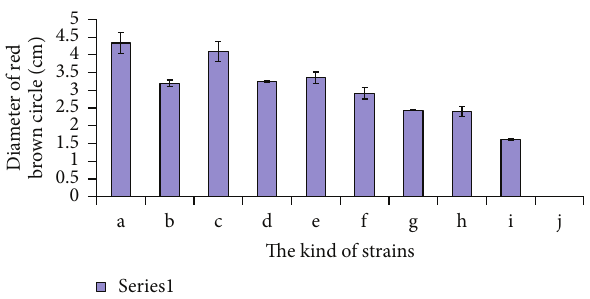
Figure 1: Diameter of red brown circle of 10 strains. One week after inoculating on guaiacol color culture media. a: Hericium erinaceus , b: Coprinus comatus , c: Lentinus edodes868 , d: Lentinus edodes939 , e: Pleurotusnebrodensis ,f: Auriculariaauricular ,g: Pholiotanameko ,h: Macrolepiota procera , i: Shiraia bambusicola , and j: Grifola frondosa . The data represent the average of three independent experiments.